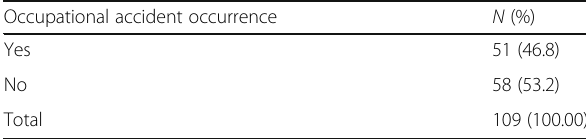
Table 3 Distribution of foundry workers by occupational accident occurrence ( N = 109) in Tehran, Iran,